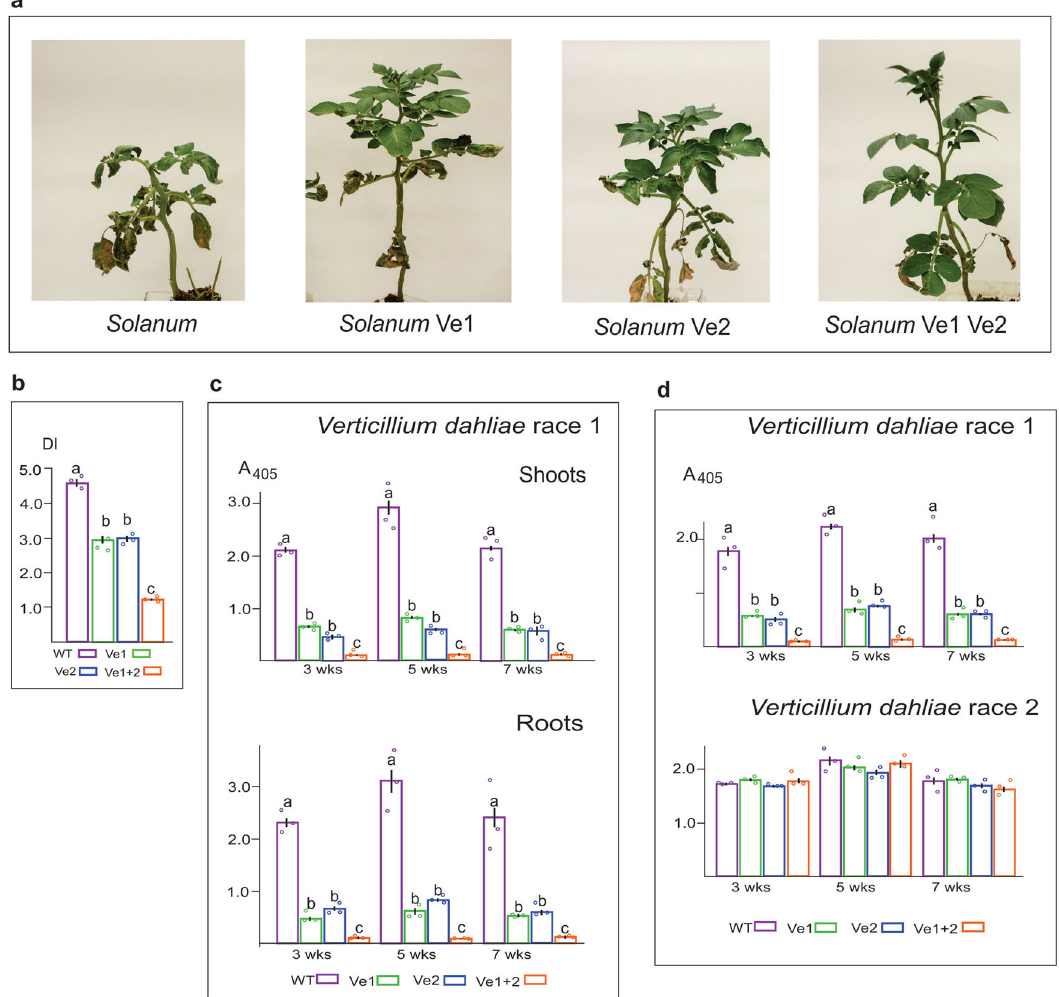
Fig. 1 Plant innate immunity levels in stably transformed Solanum tuberosum . a Disease wilt and necrosis fi ve weeks after inoculation with an aggressive isolate of Verticillium albo-atrum race 1. Suspensions of 10 7 /ml conidia were introduced into the wounded roots of 5 week old tissue culture potato plantlets stably transformed with each of the native Ve genes transcribed by the CaMV35S promoter. Images are representative plants from three independent experiments. Disease symptoms progress from the soil to the apex with wilting, chlorosis, and necrosis of leaves proceeding leaf loss. b Disease index (DI) means and standard error of the means were determined for 50 plants of each genotype, rated 10 weeks postinoculation with V. albo-atrum race 1, according to the percentage of tissue visually showing symptoms from three ( n ) independent experiments. Signi fi cance was determined using one-way ANOVA followed by Turkey-Kramer multiple comparisons ( p < 0.001) and indicated by different letters for each time point. c Pathogen titers were determined 3, 5, and 7 weeks postinoculation with V. dahliae in roots and shoots of each potato plant using double antibody serological (DAS) enzyme linked immunosorbent assay (ELISA) and absorbance determined at a wavelength of 405 nm. Means and standard error of the means were determined six inoculated plants from three ( n ) independently replicated experiments. A signi fi cant reduction in pathogen titre ( p < 0.001) was observed in those tissues transformed with Ve1 and Ve2, reducing pathogen titers to 2% of that detected in the controls. d Plants of stably transformed potato were also inoculated with either Verticillium dahliae race 1 isolate or race 2 isolate. Pathogen titers were determined in shoots of plants at 3, 5, and 7 weeks postinoculation with DAS ELISA. Results show that there was no immunity to race 2 of the pathogen even in the plants possessing the Ve1 and